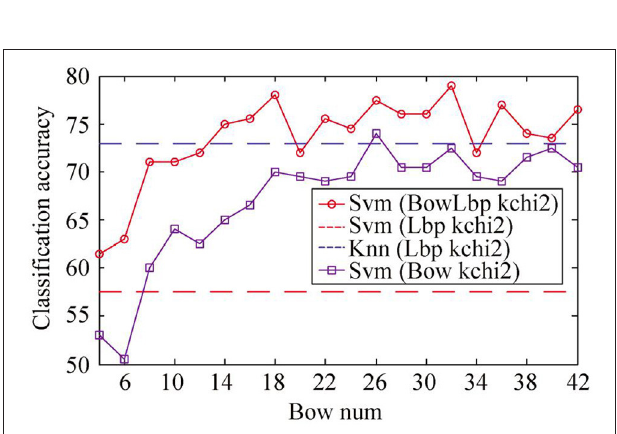
FIGURE 8 | Comparison between BowLbp feature and single feature on sample set